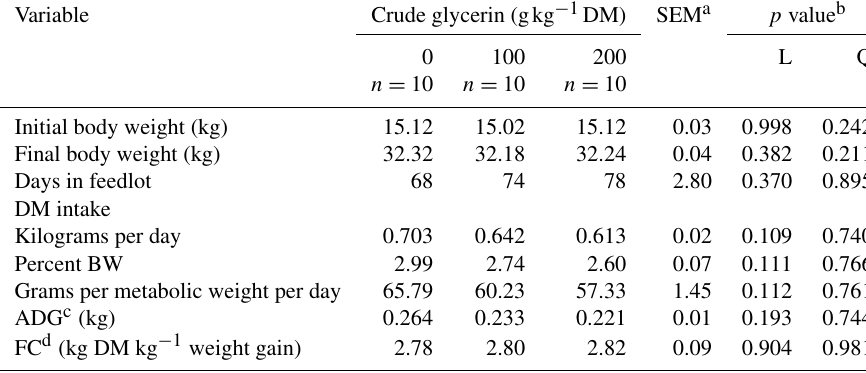
Table 5. Performance of feedlot lambs fed diets containing crude glycerin.